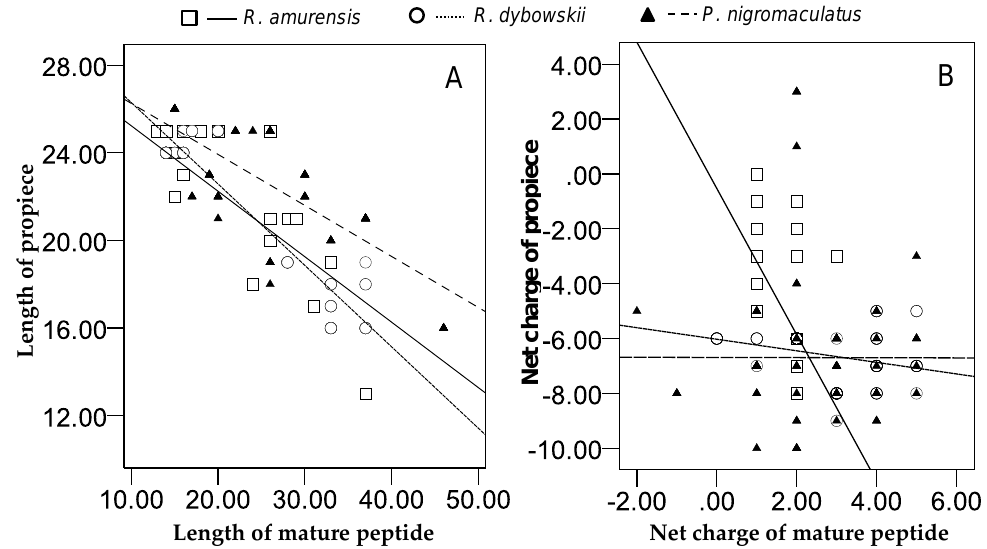
Figure 12. Relationship between the acidic propiece and the mature peptide of antimicrobial peptides (AMPs) identified from three anuran species. A: The linear correlation between the length (the number of amino acid residues) of the propiece and the mature peptide ( R. amurensis : r = − 0.645, p = 0.000; R. dybowskii : r = − 0.931, p = 0.000; P. nigromaculatus : r = − 0.858, p = 0.000); B: linear correlation between the net charges of the propiece and the mature peptide ( R. amurensis : r = − 0.399, p = 0.000; R. dybowskii : r = − 0.311, p = 0.005; P. nigromaculatus : r = 0155, p = 0.113).